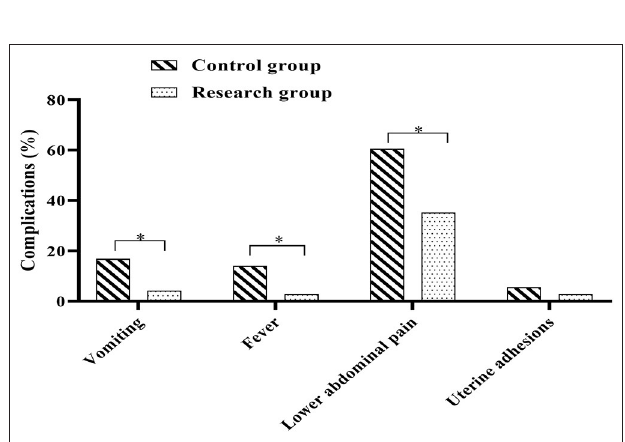
FIGURE 5 | Comparison of post-operative complications between the two groups. Comparison between the two groups, * P < 0.05.